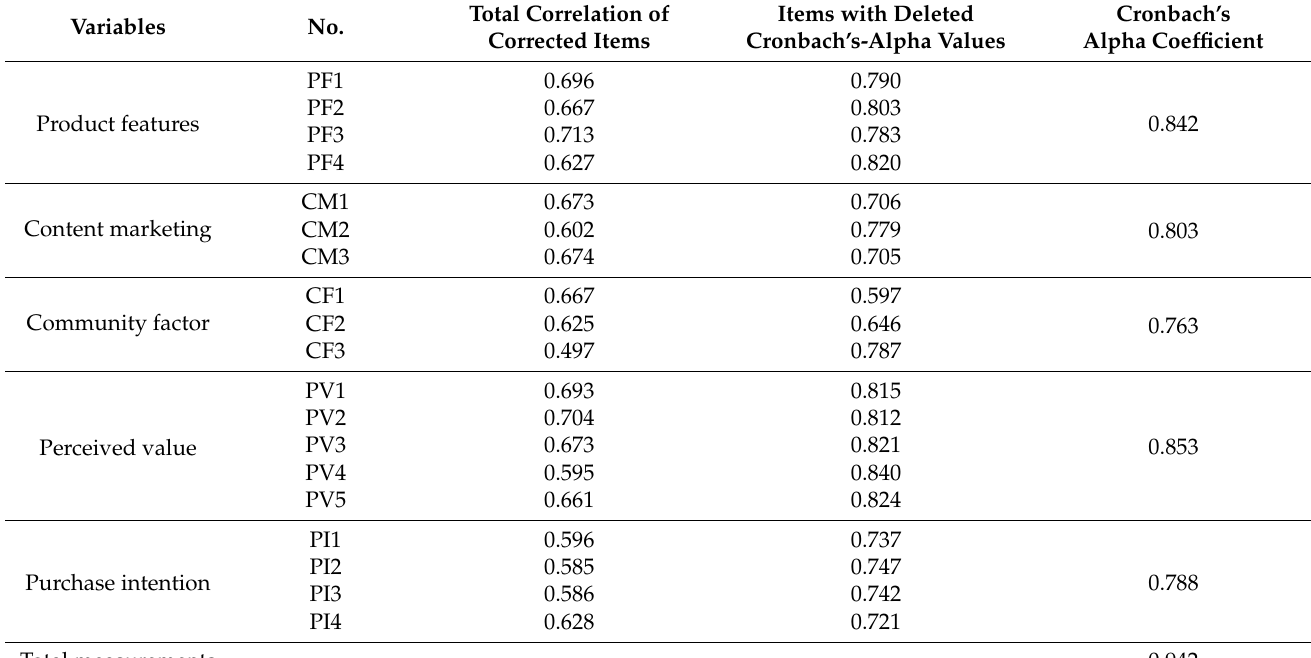
Table 3. Reliability Test Results.